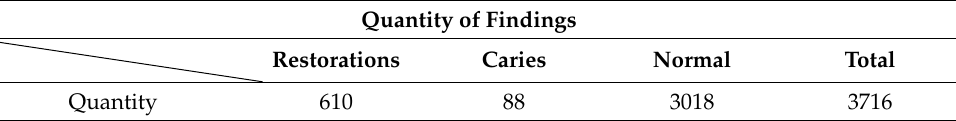
Table 1. Number of bitewing findings for clinical application.